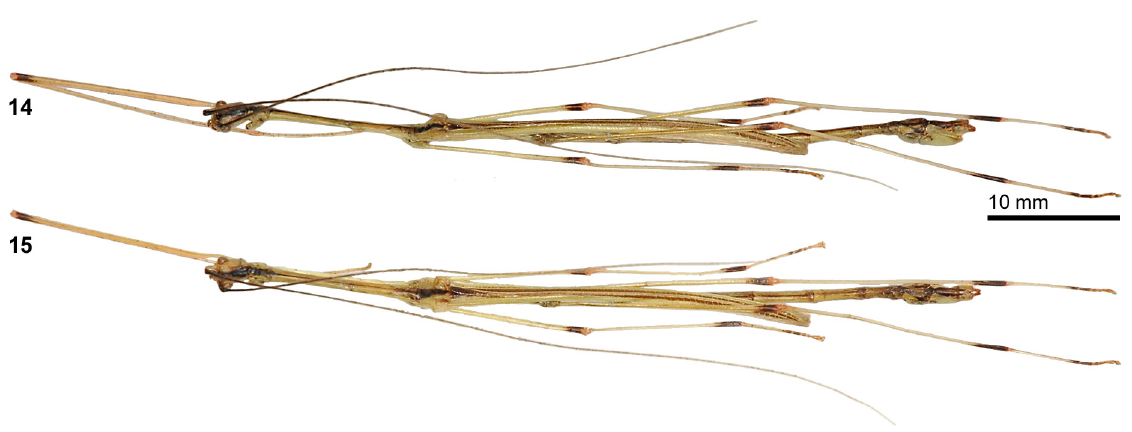
Figs 14–15. Phantasca amabilis sp. nov. Holotype, ♂ . 14 . Habitus, dorsolateral view. 15 . Habitus, dorsal